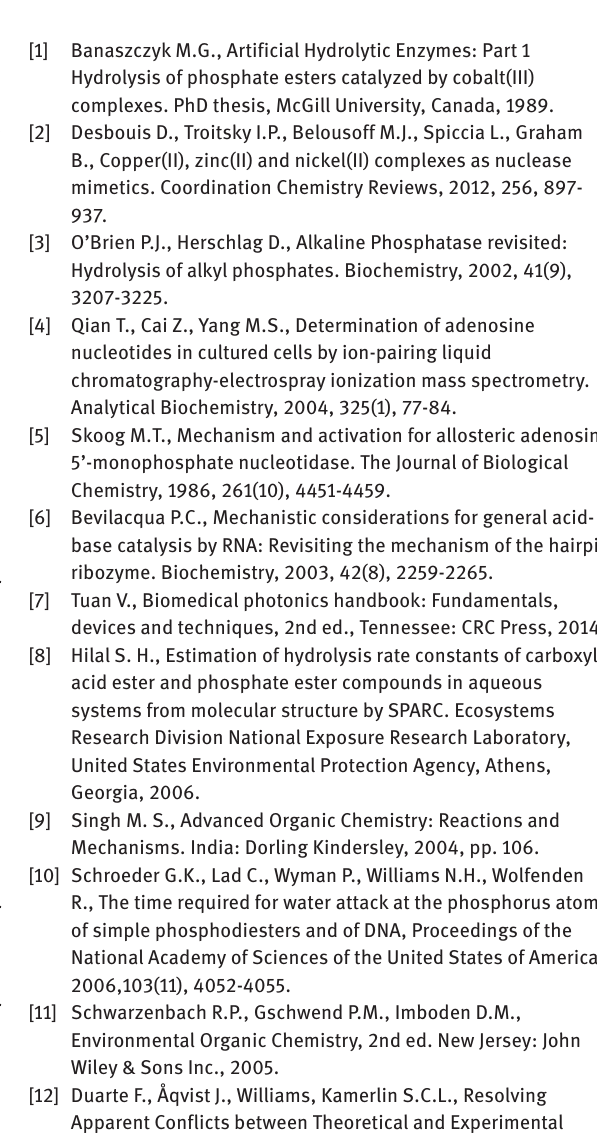
parameters (k , E A and ∑di 2 ) for alkaline hydrolysis obs app, ∞ of AMPNa of this investigation. 2 SI-2: Table consisting of [HCl], pH, and the kinetic parameters (k , E A and ∑di 2 ) for acidic hydrolysis of obs app, ∞ AMPNa of this investigation. 2 SI-3: Table consisting of [TRIS], [glycine], pH, and the kinetic parameters (k , E A and ∑di 2 ) for hydrolysis of obs app, ∞ AMPNa of this 2